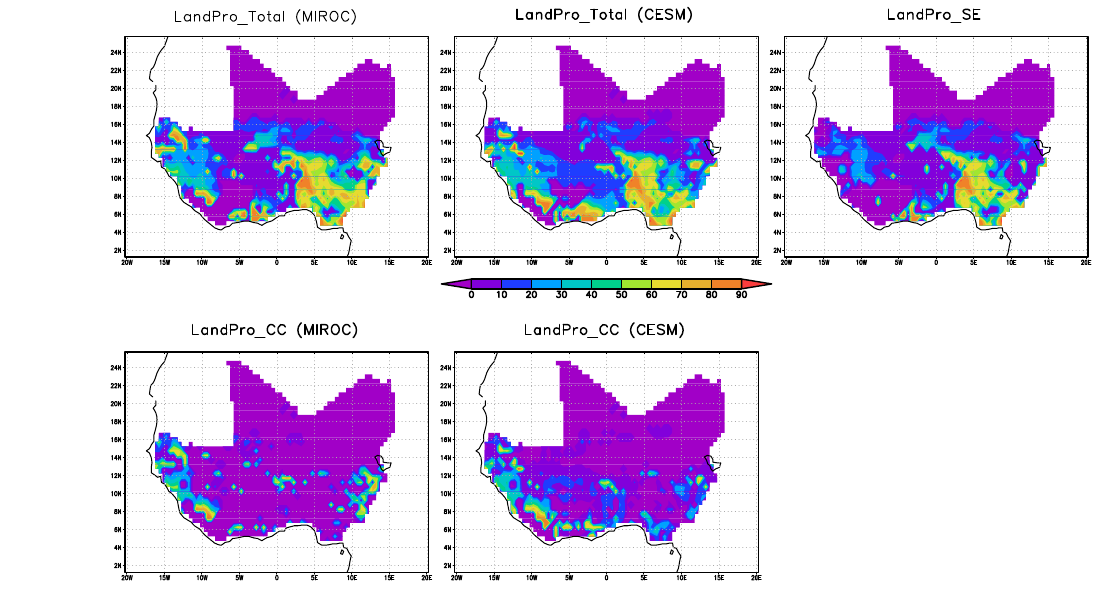
Figure 2. Future changes in crop area distribution projected by LandPro: total changes (LandPro_Total), changes because of socioeconomic changes (LandPro_SE), and changes because of climate change (LandPro_CC) in West Africa under the MIROC-driven and CESM-driven future